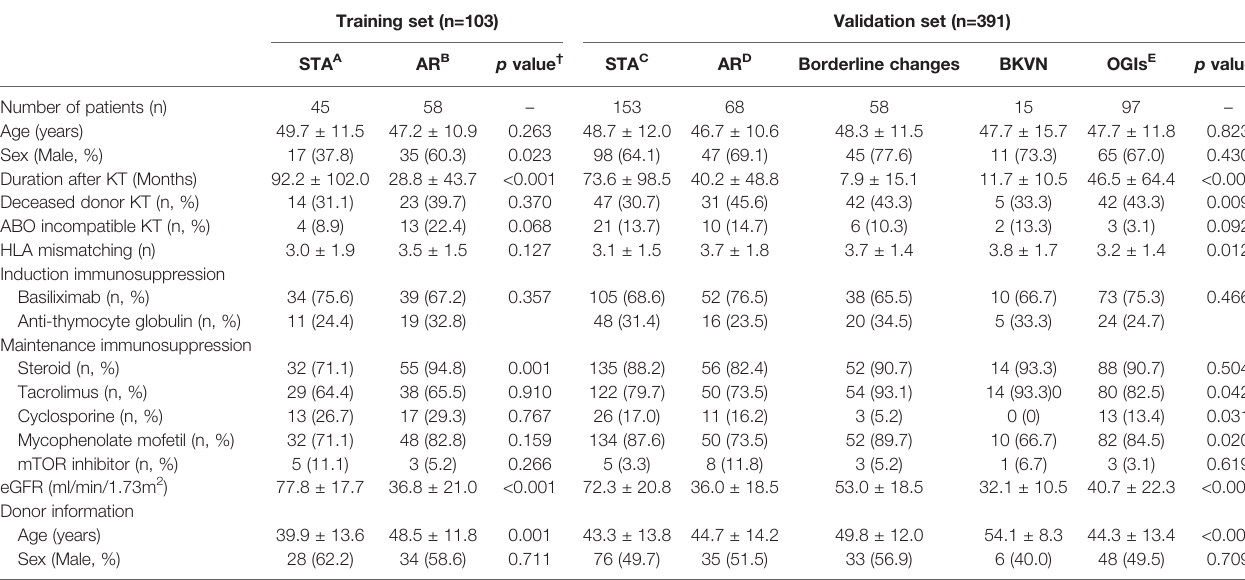
TABLE 1 | Baseline characteristics and clinical parameters of enrolled patients by study